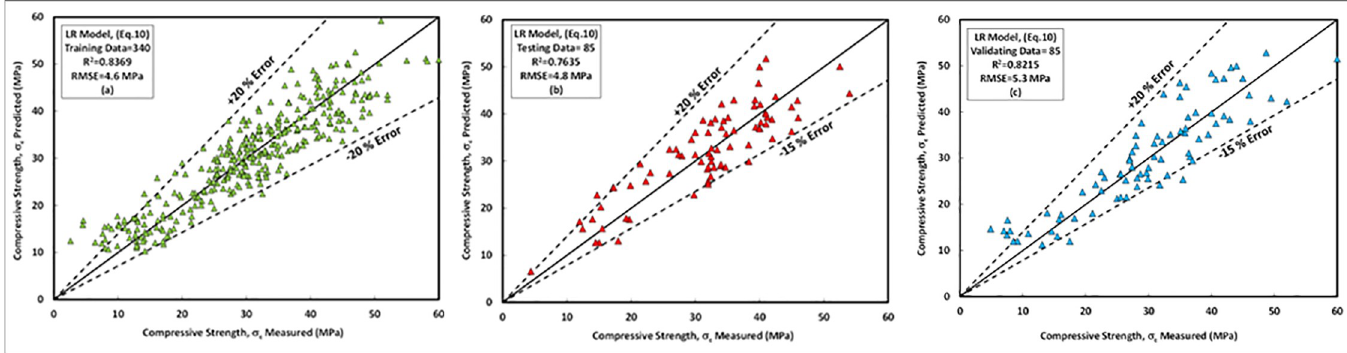
Fig 14. Comparison between measured and predicted compressive strength of fly ash-based geopolymer concrete mixture using LR model, (a) training data, (b) testing data, (c) validating data. https://doi.org/10.1371/journal.pone.0253006.g014 PLOS ONE | https://doi.org/10.1371/journal.pone.0253006 June 14,